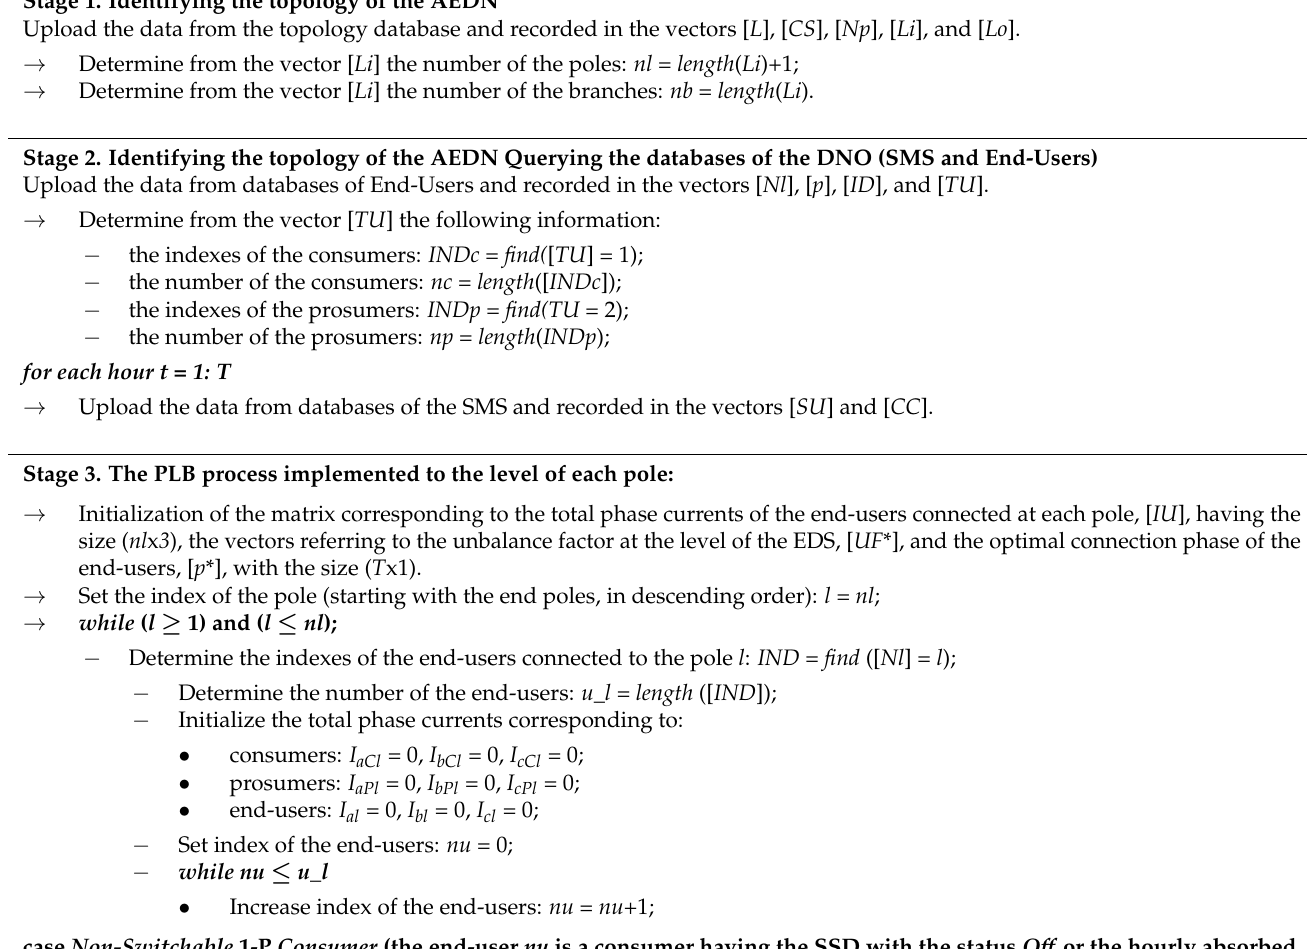
Table 3. The implementation procedure of the proposed PLB methodology. Stage 1. Identifying the topology of the